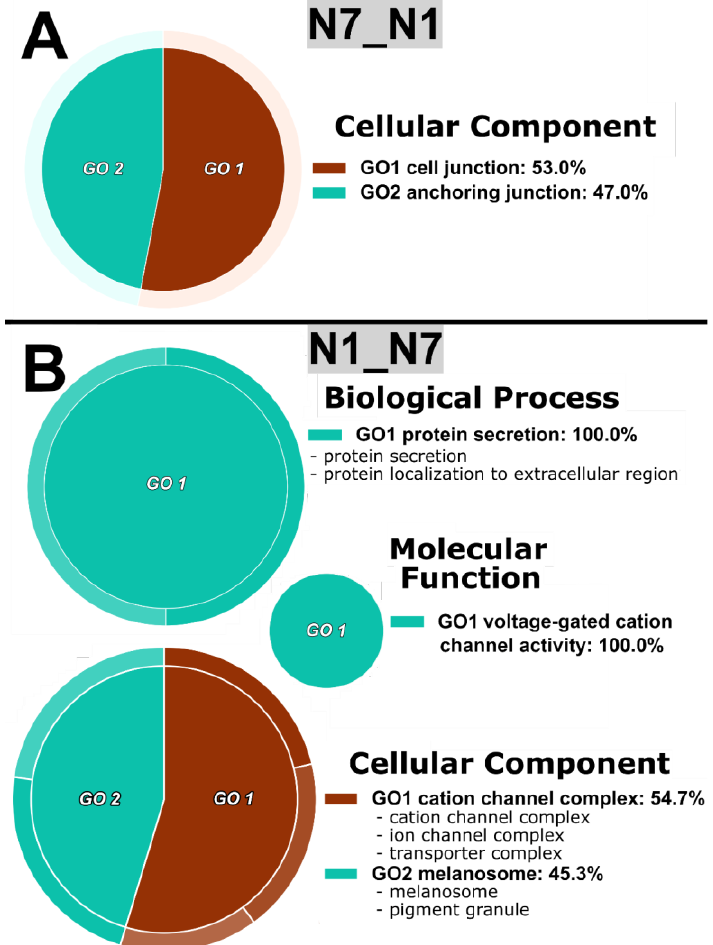
Figure 1. Functional enrichment analyses for non-bloodfed A. aegypti midguts. ( A ), circular gene ontology (CirGO) representations of reduced and visualized gene ontology (REVIGO) terms in the non-bloodfed/dehydrated group over the non-bloodfed/non-dehydrated group (N7_N1); ( B ), CirGO-REVIGO representations for the non-bloodfed/non-dehydrated group over the non-bloodfed/dehydrated group (N1_N7). REVIGO groupings are included in Supplementary Table S3 and significant g:Profiler terms are included in Supplementary Table S 4 with “intersections” indicating the genes responsible for GO categorization. CLC labels represent significant transcripts identified with the QIAGEN CLC pipeline; DK, the DESeq2-Kallisto pipeline; and DS, the DESeq2-Sailfish pipeline.